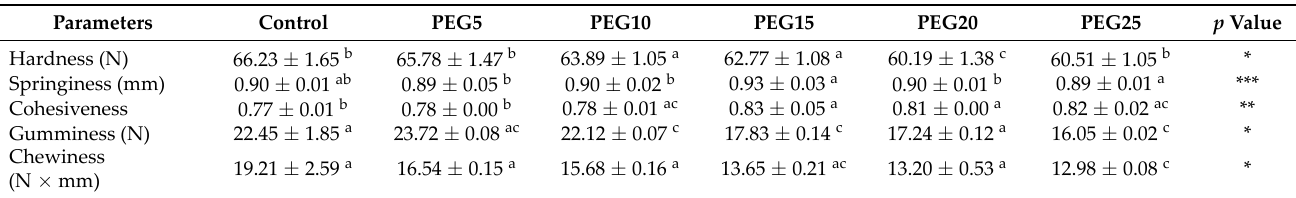
Table 6. Texture profile analysis of semi‑smoked